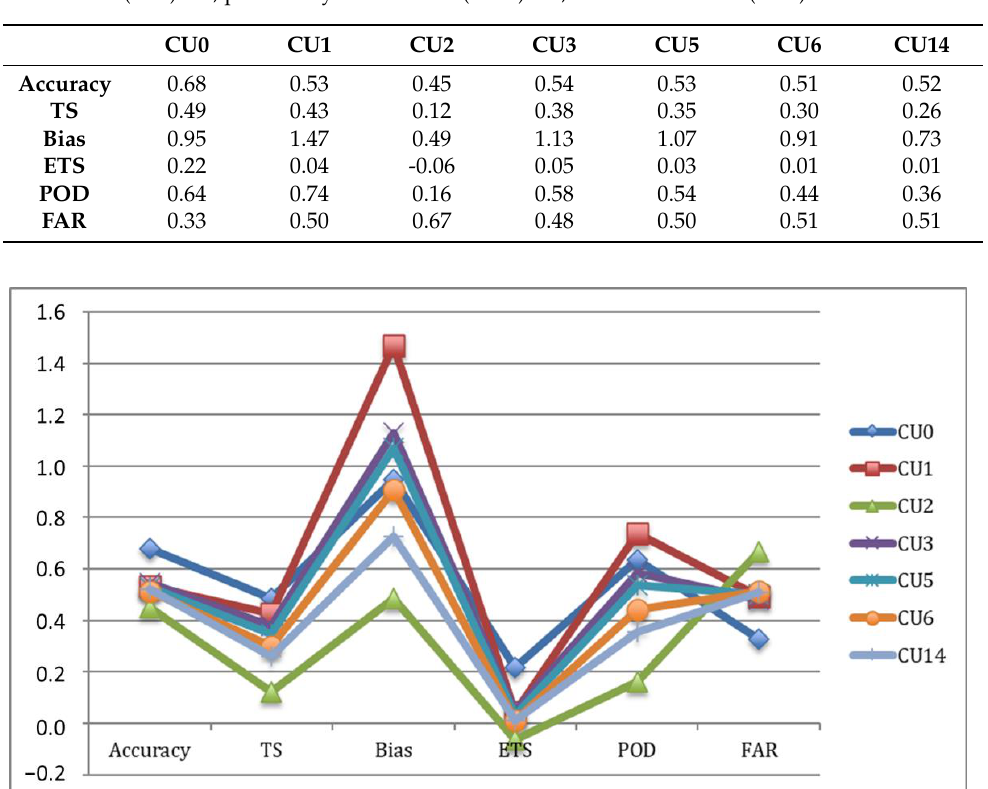
Table 4. Numeric values of indexes were calculated for each simulation performed by modifying the physical parameterization of the convective processes of the WRF model. For the analysis, all the selected meteorological stations and the respective points of the WRF model were taken into consideration. The ideal values are: accuracy (hit rate) = 1; threat score (TS) = 1; bias = 1; equitable threat score (ETS) = 1; probability of detection (POD) = 1; false alarms ratio (FAR) = 0.